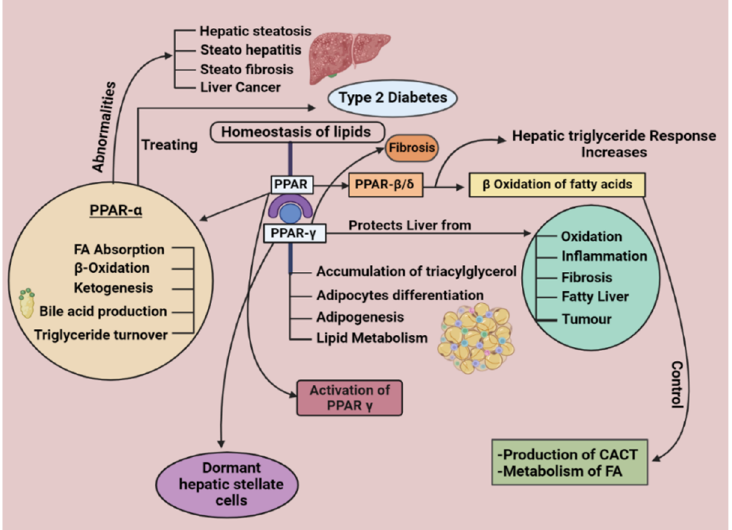
Figure 1. This illustration represents the regulatory mechanisms of PPARs involved in NAFLD. It gives a complete overview of the various PPARs (PPAR α , PPAR γ , and PPAR β / δ ) and their critical roles and mechanisms in the body.